Question: Briefly state, in one sentence, what is plotted here.
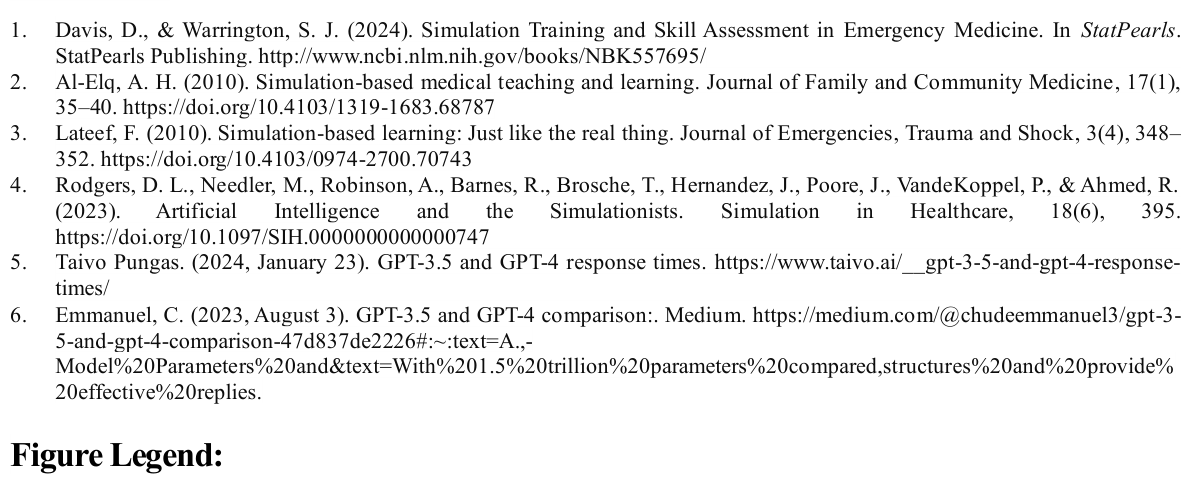
Answer: Automated Scenario Generation Process Flow